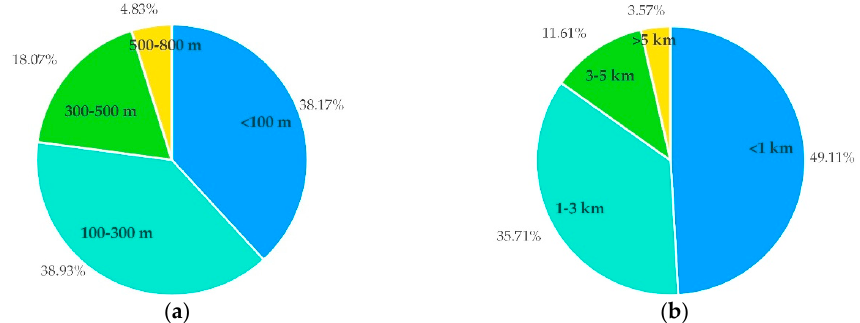
Figure 4. The preferences for the distance of dishwashing facilities, ( a ) for the consumers and ( b ) for the merchants.